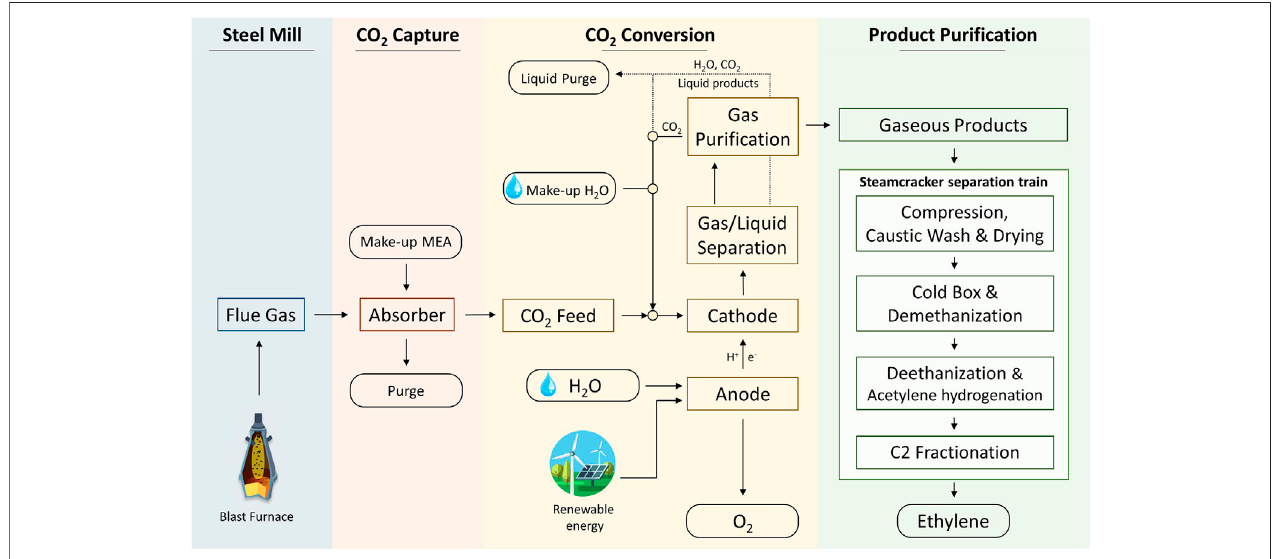
FIGURE 5 | Envisioned process scheme for the electrochemical conversion of a CO 2 -containing fl ue gas stream to high-value chemicals.